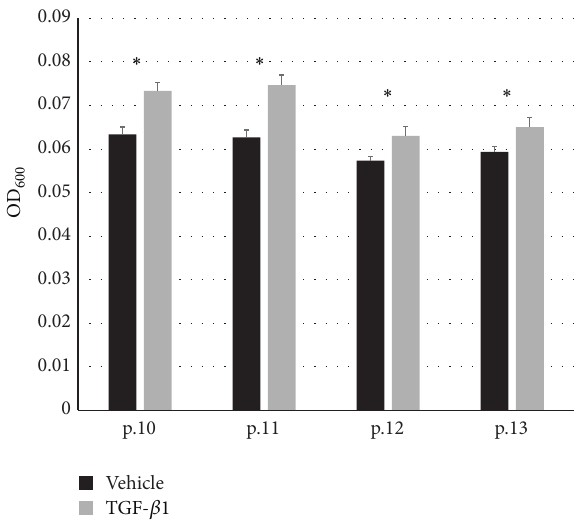
Figure 5: Migration assay of HSMP cultured with/without TGF- 𝛽 1. Migration assay was performed as described in Methods using cells ofpassages10–13.Absorbanceat600 nm(OD 600 )ofmigratedHSMP stained with hematoxylin. ∗ 𝑝 < 0.05 versus